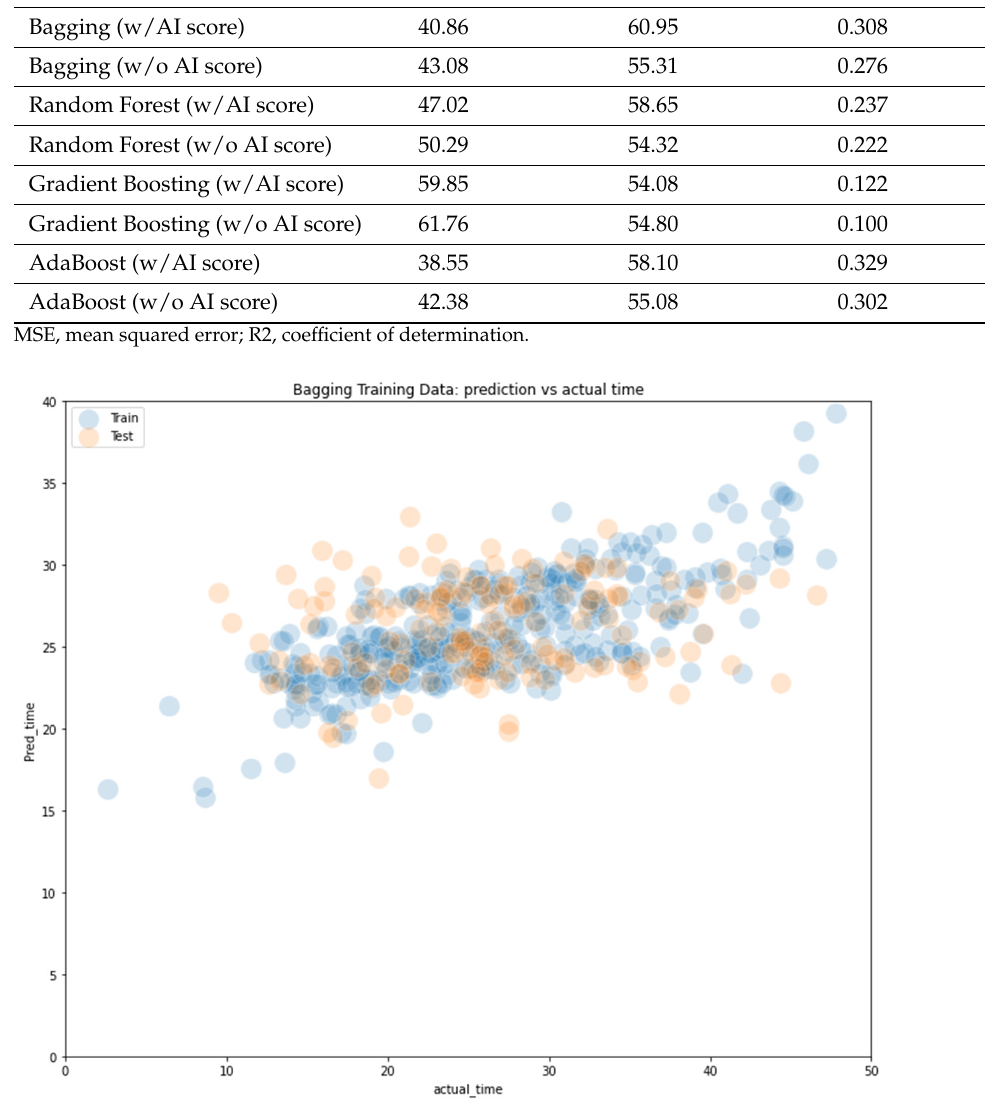
Figure 4. Scatterplots comparing actual treatment time vs predicted treatment time for the bagging model.